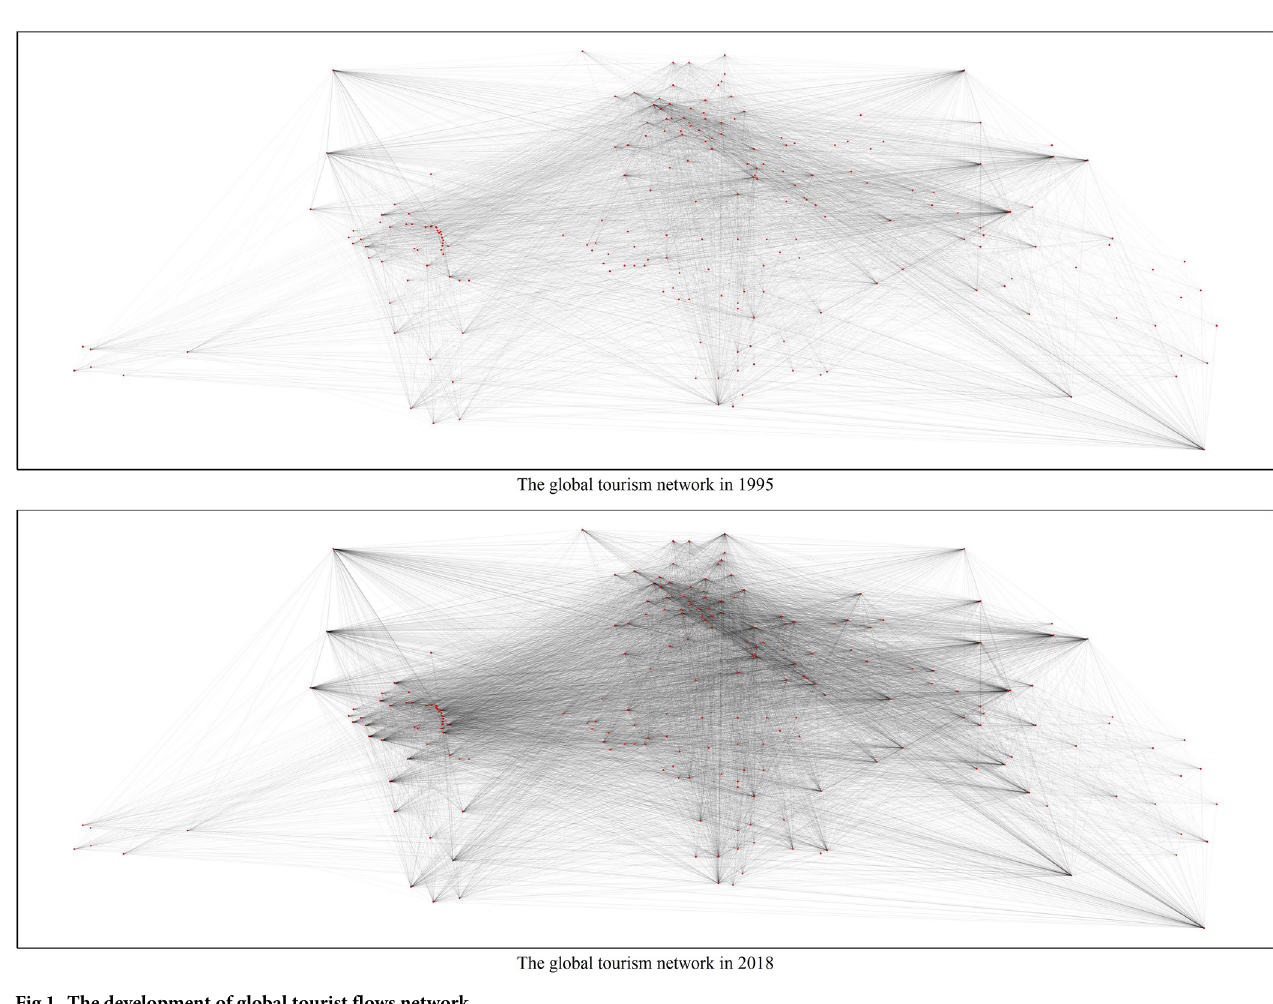
Fig 1. The development of global tourist flows